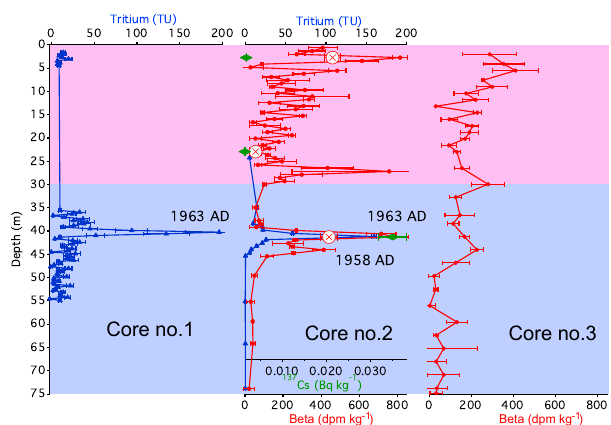
Figure 7. Physical characteristics of the Mt. Ortles cores. The tem- perate firn portion is enclosed in red shading, while the cold ice is in blue. (a) Borehole no. 3 temperatures recorded 43 days after the end of the drilling operations (from Gabrielli et al., 2012). (b) Vir- tual image of core no. 1 reconstructed from 360 ◦ Televiewer visual scanning of borehole no. 1. (c) Red component of the RGB digital signal obtained by means of visual scanning. High values indicate higher light reflection. (d) Densities of the Mt. Ortles ice cores no. 1, no. 2 and no. 3.